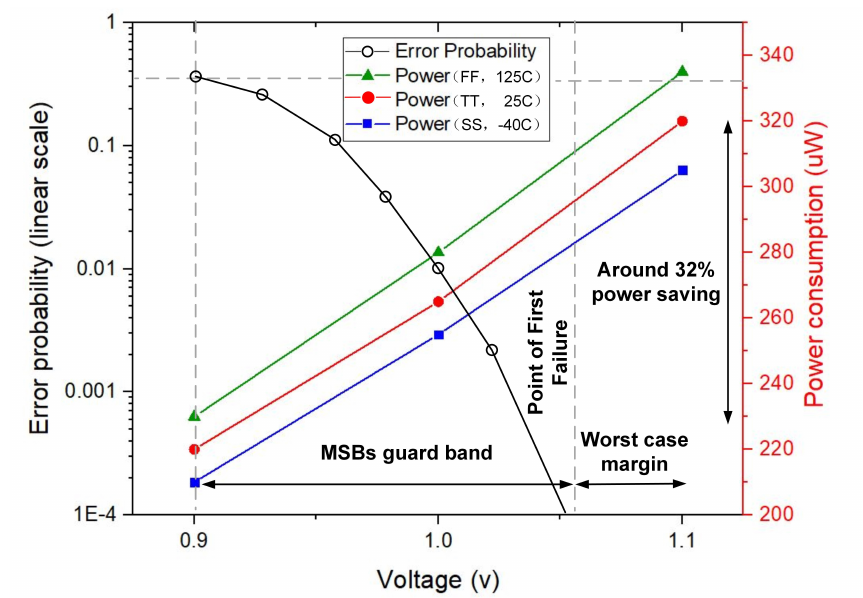
Figure 9. Power dissipation and error probability versus supply voltage with different process corners and temperature.